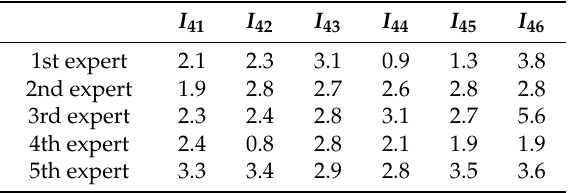
Table A20. Scores of environmental management maturity in the controlling process index.